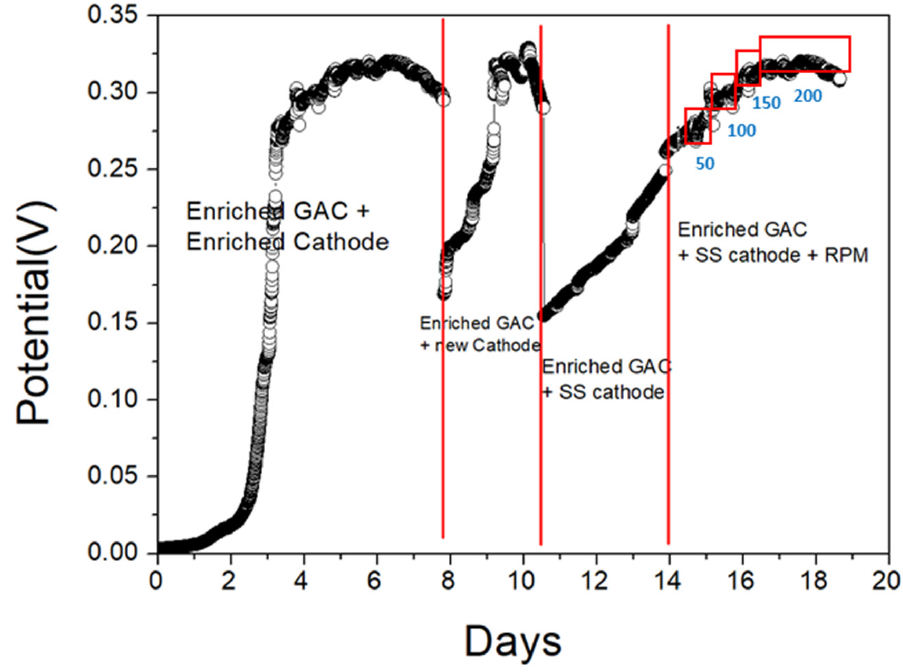
Figure 4. Denitrification MFC operated under different cathode conditions with an enriched GAC-biocathode.